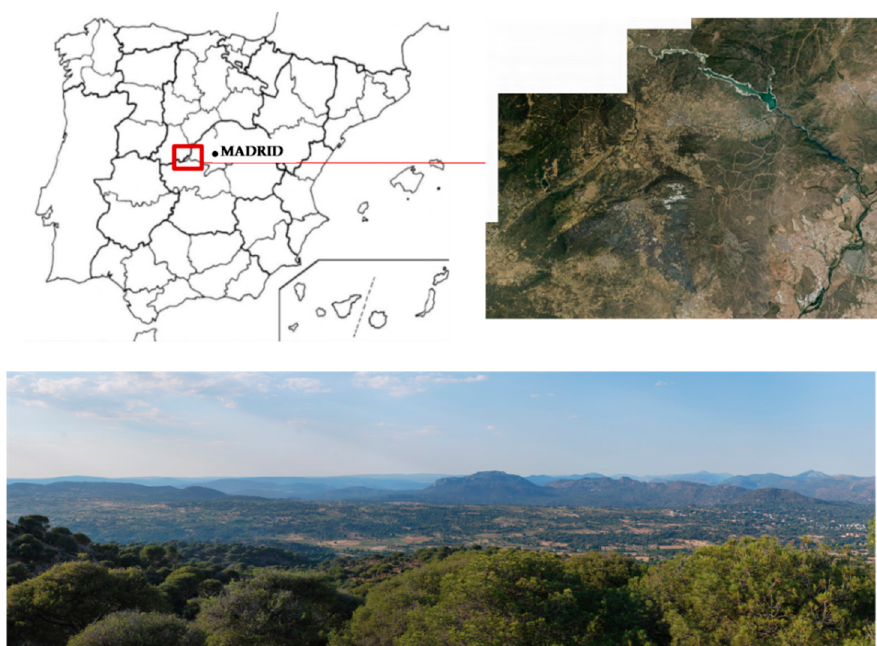
Figure 1. Location and image of the area of study.